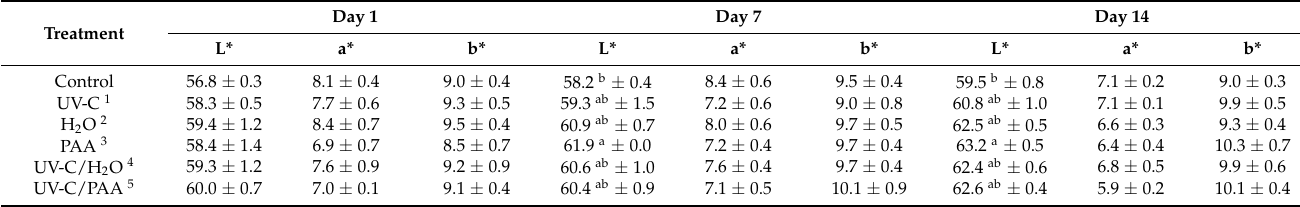
Table 6. LSM ± SE of the lightness (L*), redness (a*), and yellowness (b*) values of pork after UV-C, peracetic acid (PAA) and H 2 O treatment alone and in combinations, inoculated with Yersinia enterocolitica , after 1, 7, and 14 days of storage ( n = 3). Treatment Control